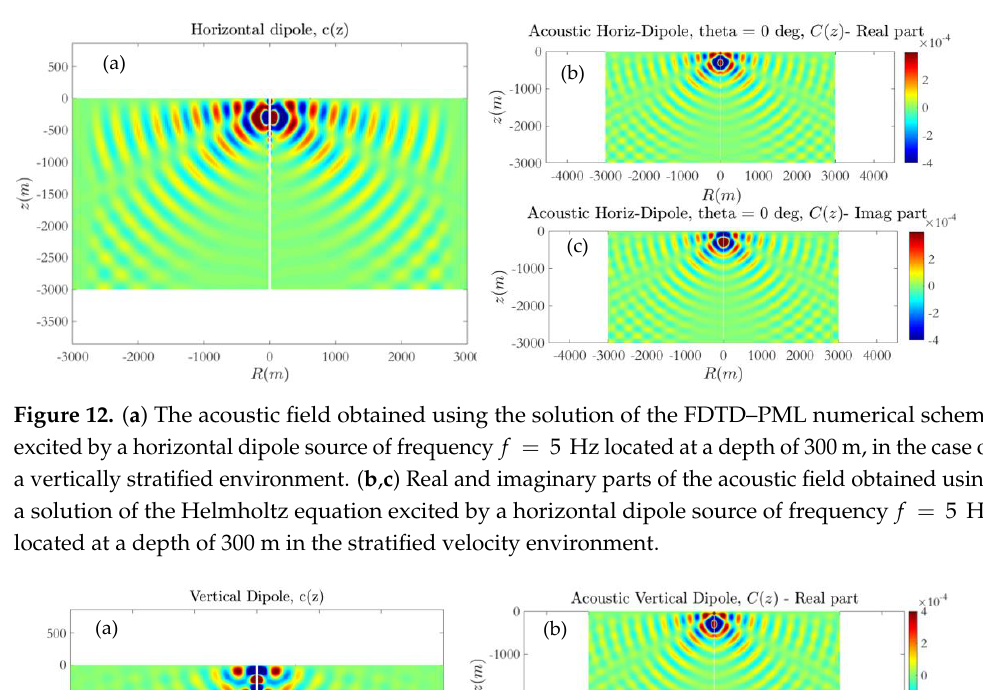
300 m in the stratified velocity environment.